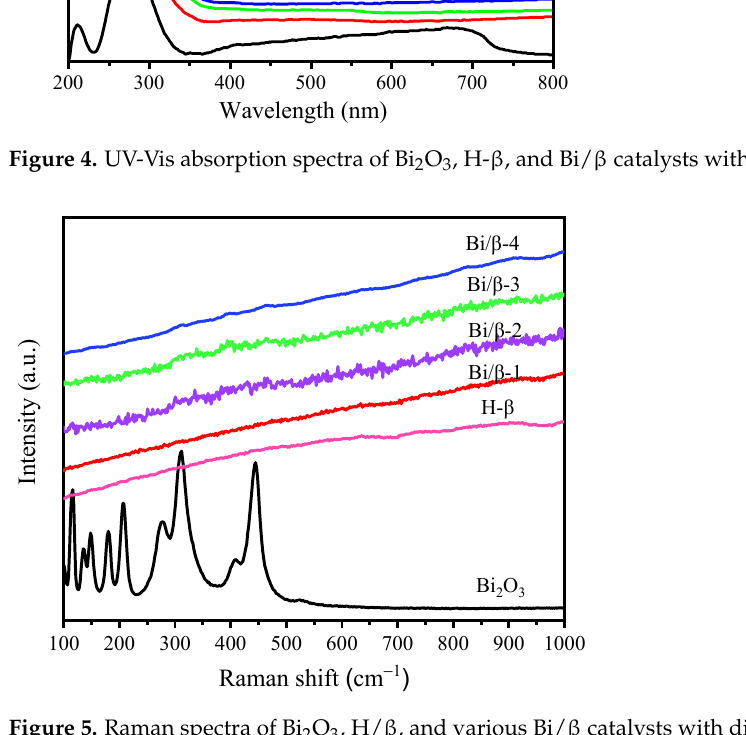
Figure 5. Raman spectra of Bi 2 O 3 , H/ β , and various Bi/ β catalysts with different Bi loading. The surface acidity and strength of catalysts were measured by NH 3 -TPD technique.